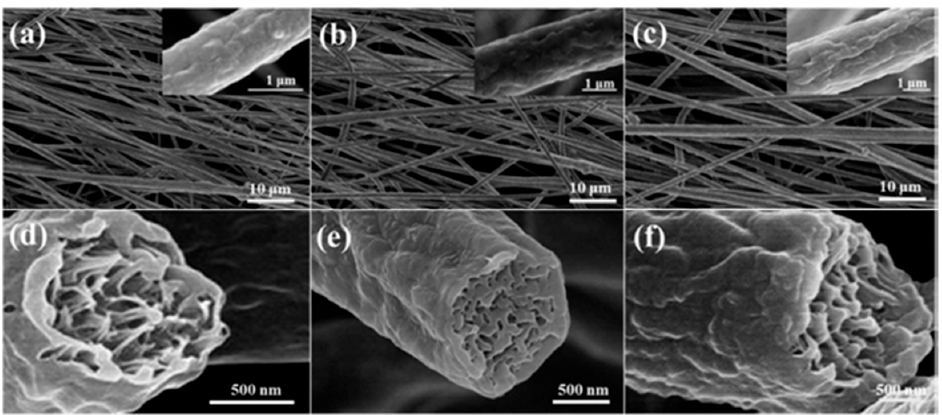
Figure 6. SEM images of aligned wrinkled electrospun PVDF fibers and their cross-section fabricated at different molecular weights. ( a , d ) Mw = 180 × 10 3 . ( b , e ) Mw = 275 × 10 3 . ( c , f ) Mw = 530 × 10 3 . Reprinted with permission from [77].